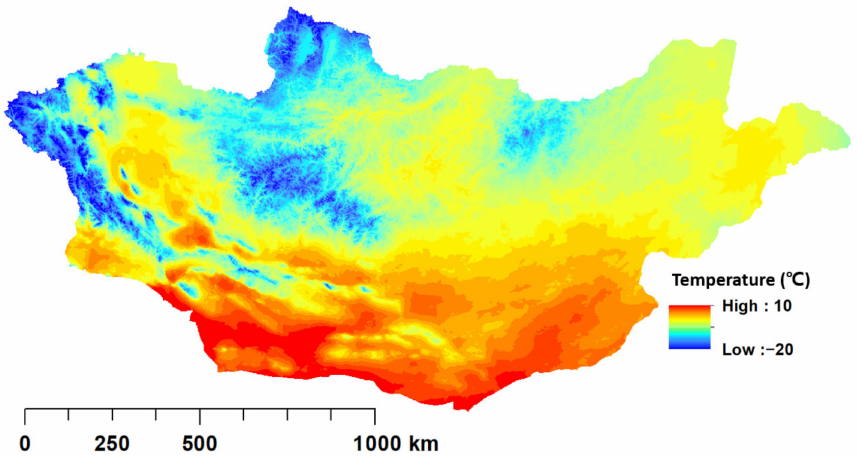
Figure 4. Annual average temperatures in Mongolia. The highlands receive more solar radiation than the lowlands. The Mongolian Plateau is the second-largest plateau in central and east Asia [26], surrounded by the Gobi Desert to the south and the southeast, at an altitude of 523–4318 m above sea level—as shown in Figure 5, which displays a digital elevation model (DEM) of Mongolia, with a resolution of 30 m.